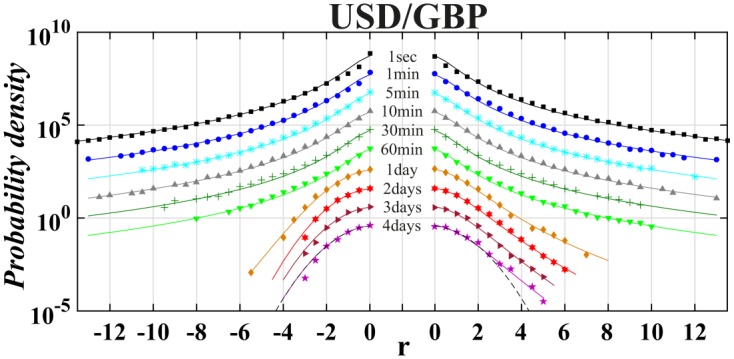
Same as in Fig 10 for USD/GBP exchange rate.